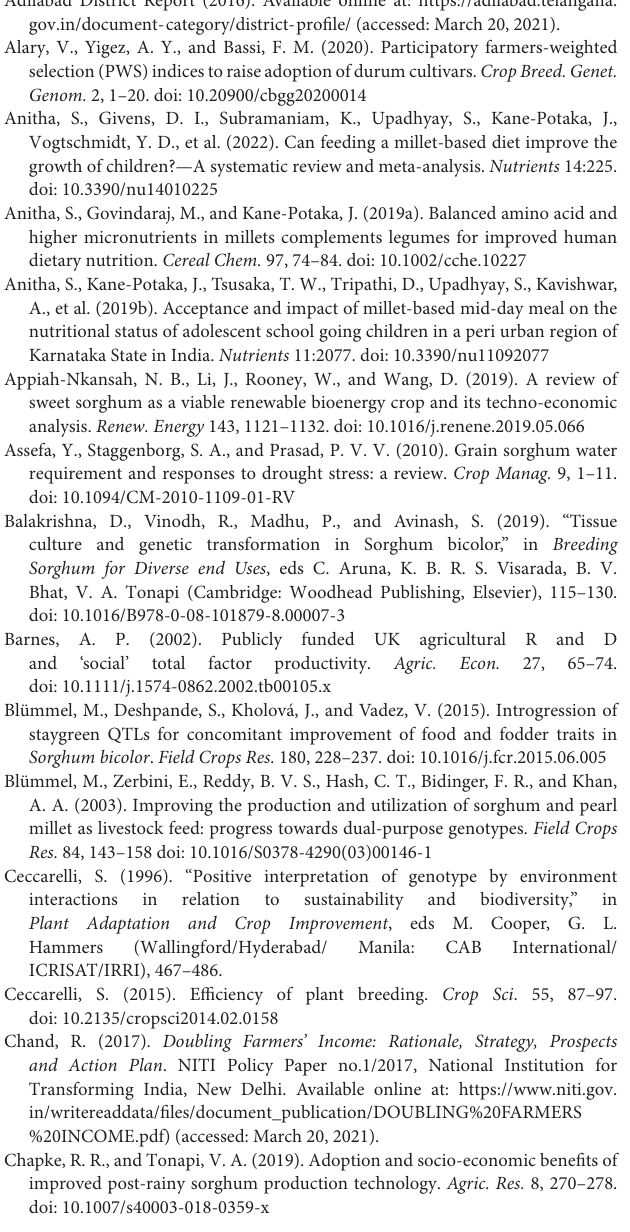
Supplementary Figure 2 | Trait relationship between stover quality (IVOMD, %) and stover yield (g plant − 1 ) in water stressed (WS) and well-watered (WW) plants across four genotypes tested in 2019–20 lysimetric trial. Crop varieties are color coded; Full circles ( • ) indicate WW plants; Open circles ( (cid:13) ) indicate WS plants; solid line (—–) indicates relationship in WW plants; dashed line (—–) indicates relationship in WS